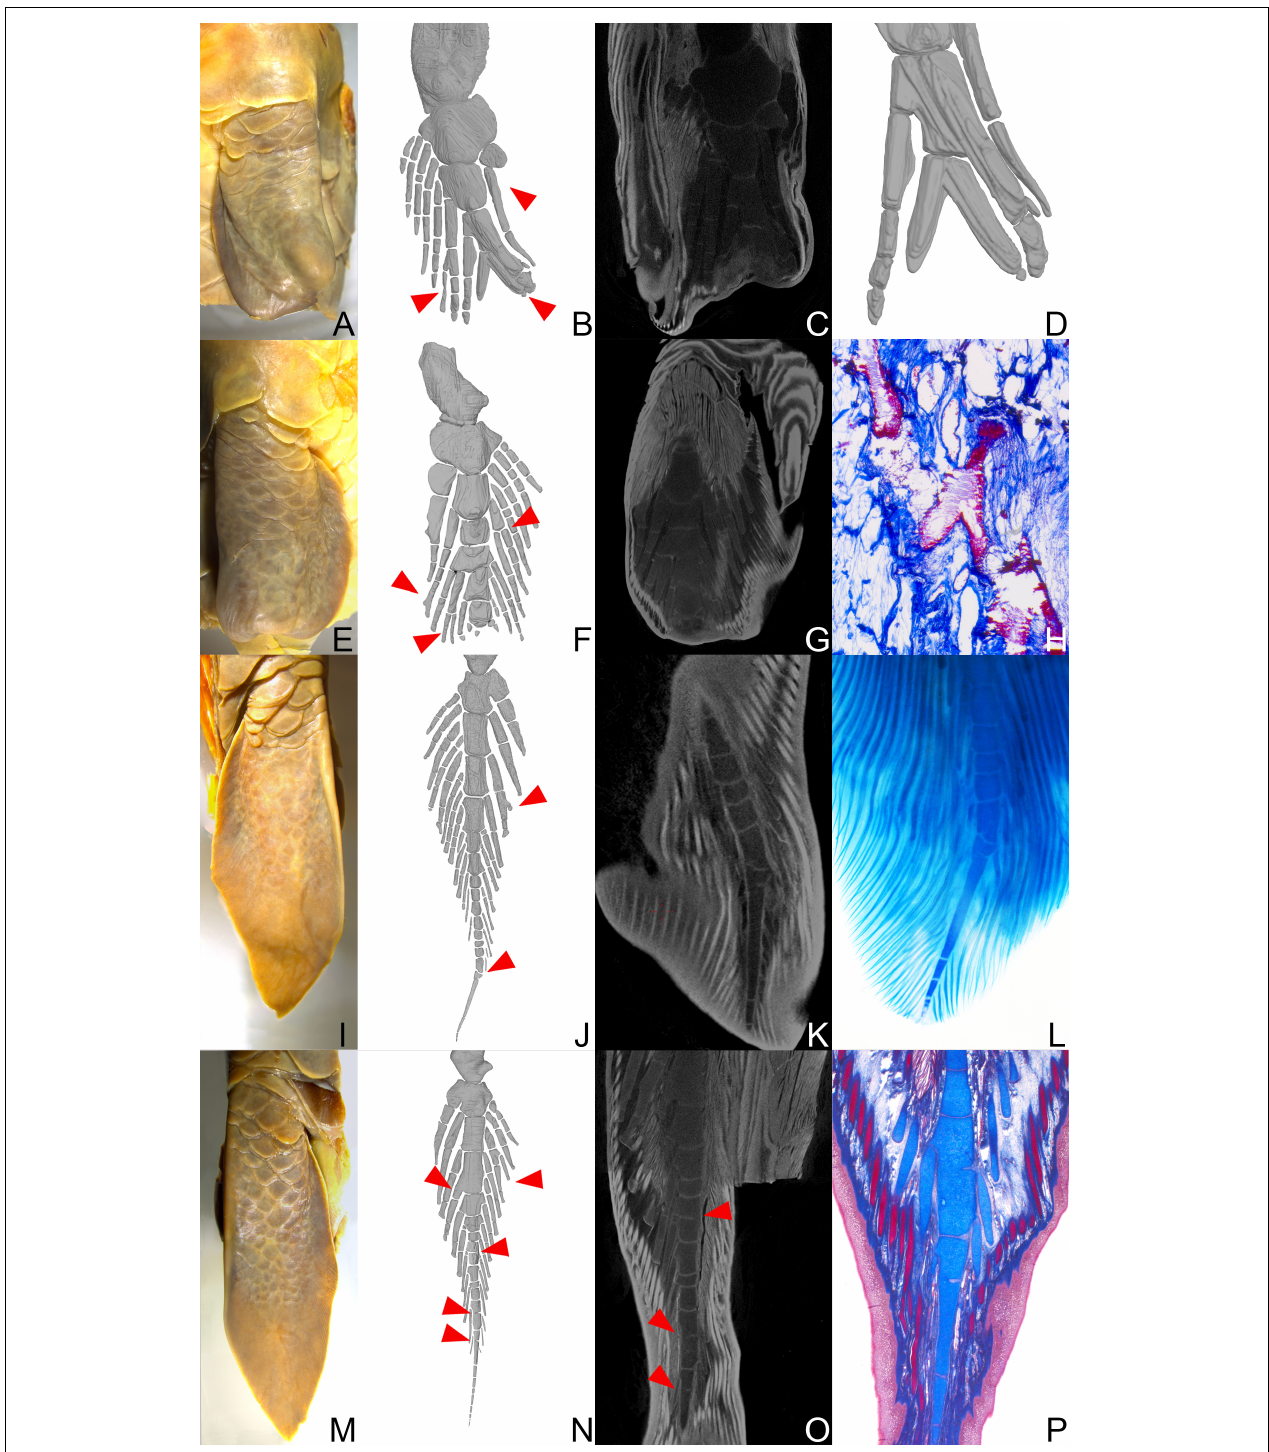
FIGURE 5 | Neoceratodus forsteri (ZMB_Pisces_33693): (A) Left pectoral fin. (E) Right pectoral fin. (I) Left pelvic fin. (M) Right pelvic fin. All fins in ventral view. (B,F,J,N) 3D reconstructions of the entire fins. (C,G,K,O) µ CT scannings. (D) Detailed 3D reconstruction of the distal fin tip. (H,P) Histological serial sections, stained with Alcian blue. (L) Clearing and double staining of the distal fin tip. Red arrows indicate striking malformations of the fin skeleton.